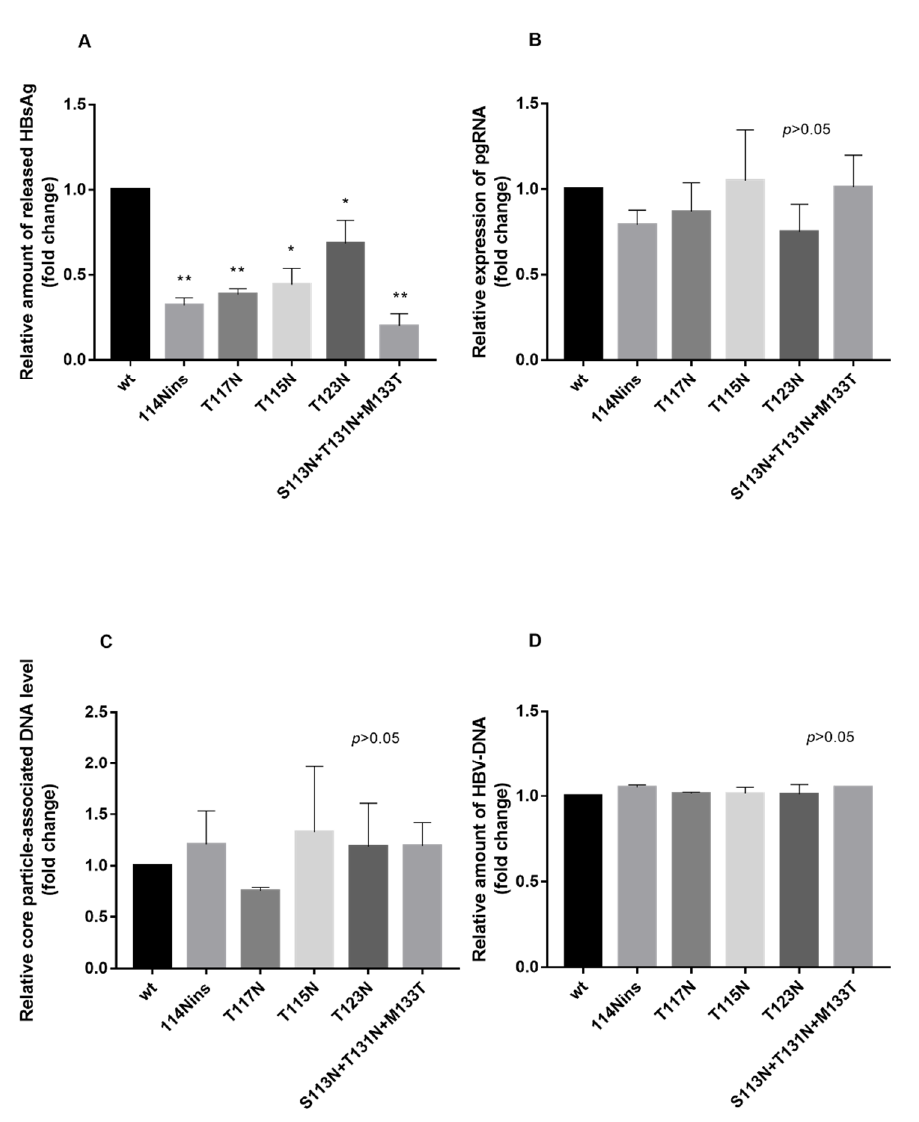
Figure 1. Impact of the additional N -glycosylation site in HBsAg MHR on viral replication by in vitro experiments. Huh7 cells were transfected with a wt and mutated Hepatitis B virus (HBV) full-genome plasmid (genotype D). 72 h post transfection the amount of HBsAg in supernatants ( A ), intracellular pre-genomic HBV-RNA ( B ) and core-associated HBV-DNA ( C ) as well as HBV-DNA in supernatants ( D ) were measured. Values are the mean ( ± SD) of at least three independent experiments each carried out in duplicate and expressed as relative amount compared to wt. HBsAg and HBV-DNA in supernatants were measured by Elecsys ® HBsAg II quant (Roche, Basel, Switzerland) and ROCHE COBAS TaqMan HBV test;v2.0 ® , respectively, while intracellular pre-genomic HBV-RNA and core-associated HBV-DNA by home-made real time PCR. Statistically significant di ff erences between each mutant and wt in the quantification of the abovementioned HBV parameters were assessed by Student’s t -test. * p < 0.05, ** p < 0.01.